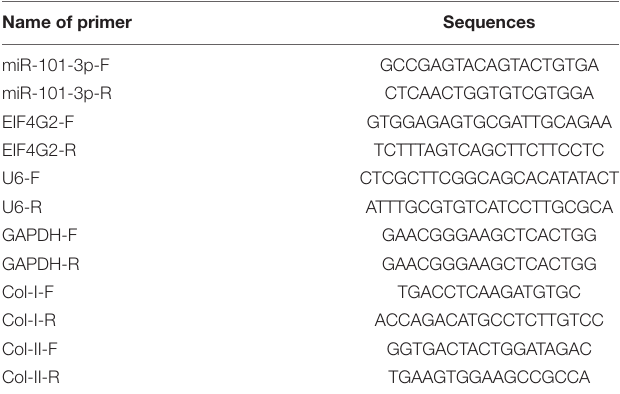
TABLE 1 | Primer sequences for